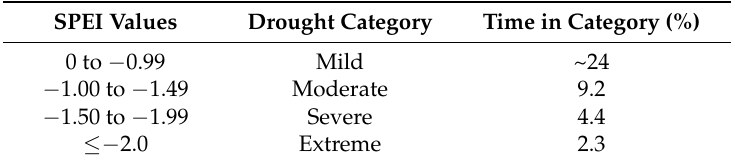
Table 1. Drought classification based on the monthly Standardised Precipitation Evapotranspiration Index (SPEI-1) values and the respective time in category, according to the classification proposed by McKee et al. [53]. SPEI